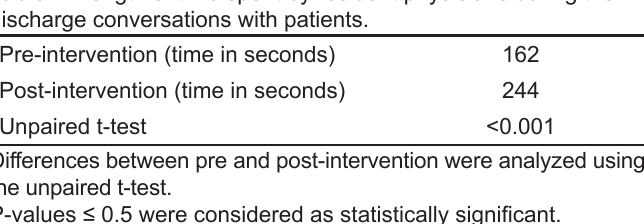
Table 4. Length of time spent by resident physicians during the discharge conversations with patients.